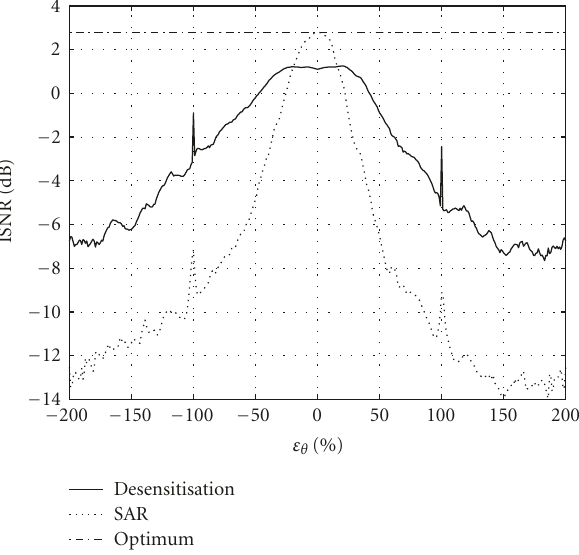
Figure 13: Distributions of ISNR obtained by both the SAR restora- tion and our desensitised method when the estimated Gaussian noise variance (BSNR = 20dB) is altered according to a relative error ε σ leaving the PSF estimation unchanged (motion blur). Be- sides, a horizontal line is included symbolizing the constant value of ISNR reached when optimum estimates are considered in the SAR filter.